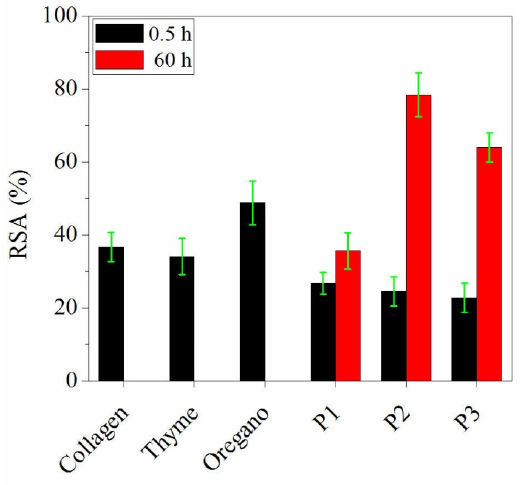
Figure 4. The DPPH radical-scavenging activity for collagen, thyme essential oil, oregano essential oil and nanospun samples (P1, P2 and P3).